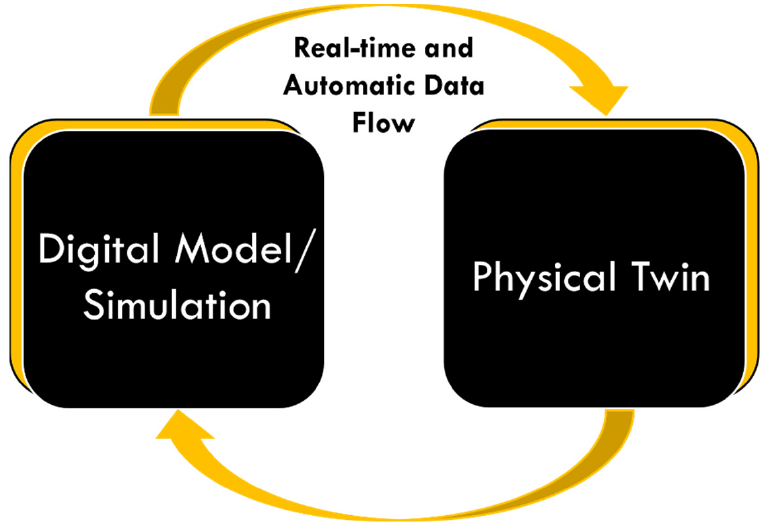
Figure 1. Block diagram of a digital twin.